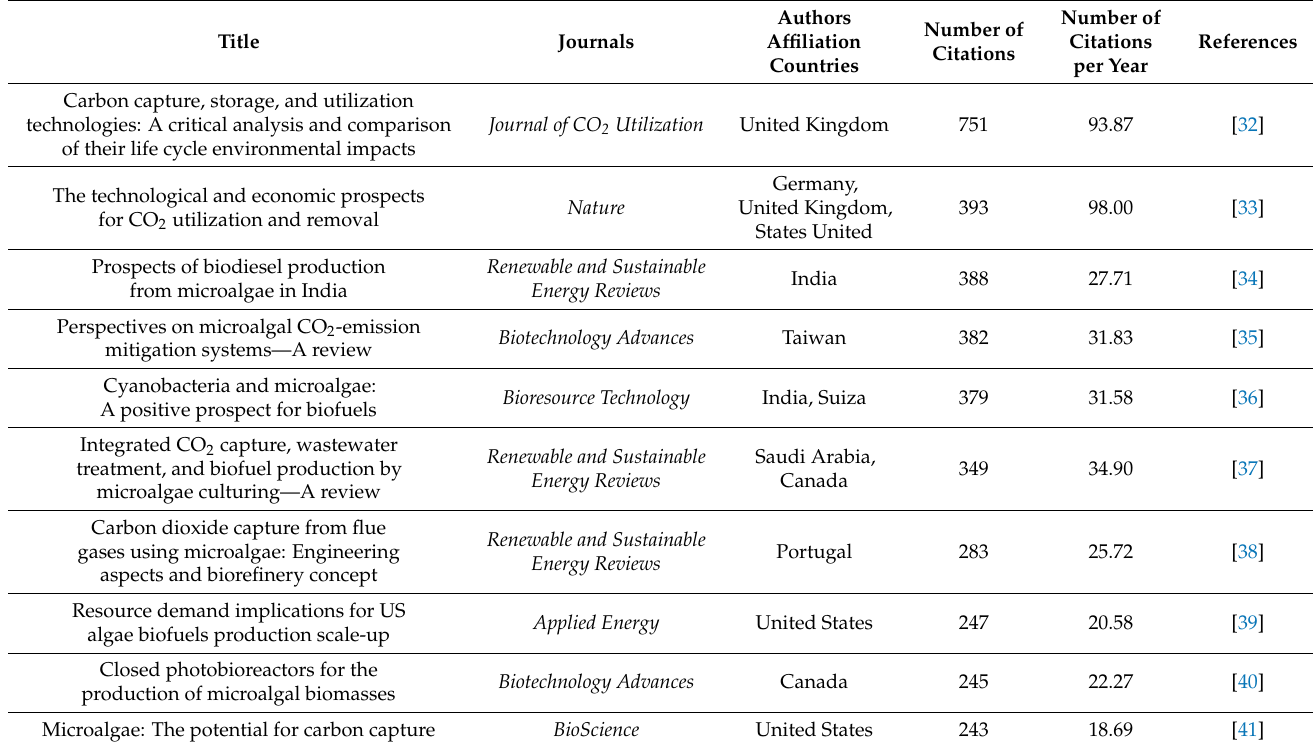
Table 1. Documents with the highest citations in global research on CO 2 capture with